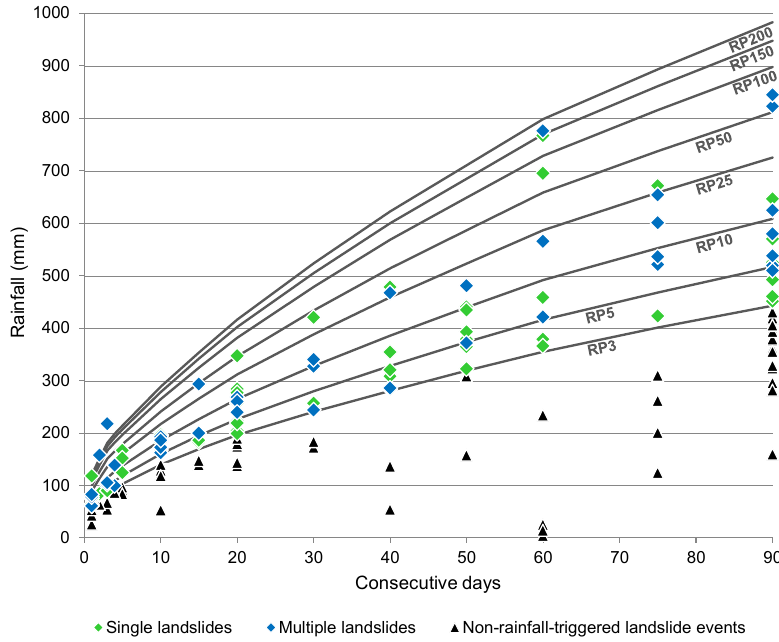
Figure 6. Critical combination cumulated rainfall duration that resulted in landslide events (single and multiple landslides) and return period (RP) for 3, 5, 10, 25, 50, 100, 150 and 200 years. Distance up to 10km from the reference rain gauge. The non-rainfall-triggered landslide events identified are also